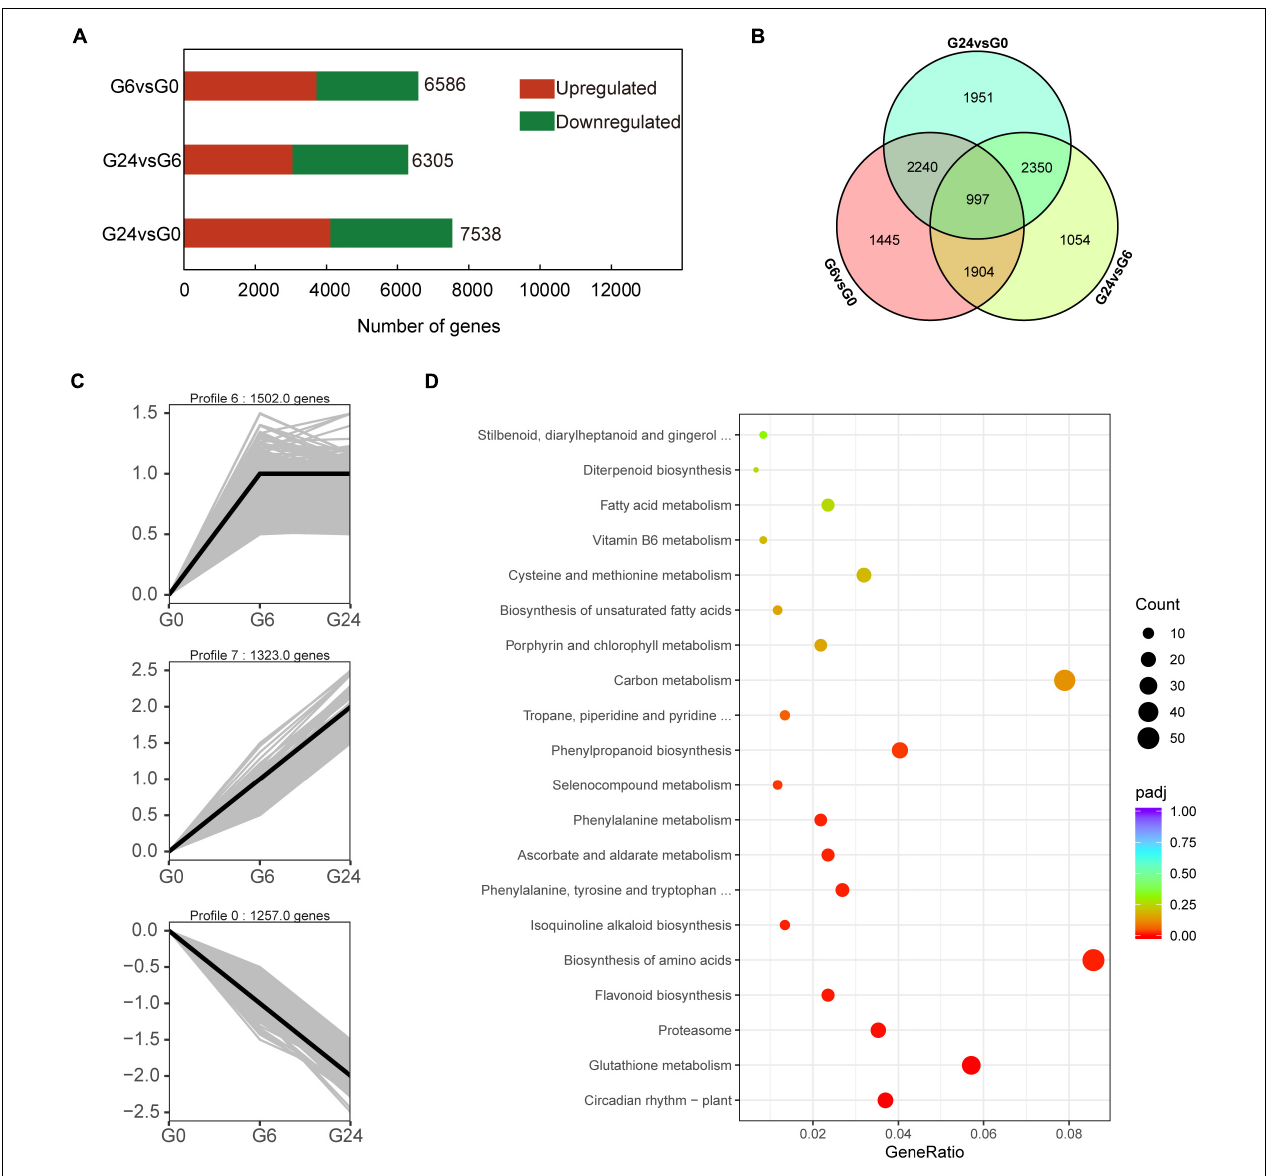
FIGURE 2 | Identification of DEGs and KEGG analysis. (A) Number of DEGs between samples. (B) Venn diagram representation of DEGs from pairwise comparisons. (C) Three significant gene expression profiles. (D) KEGG pathway enrichment analysis of differentially expressed transcripts in profiles 0, 6, and 7.